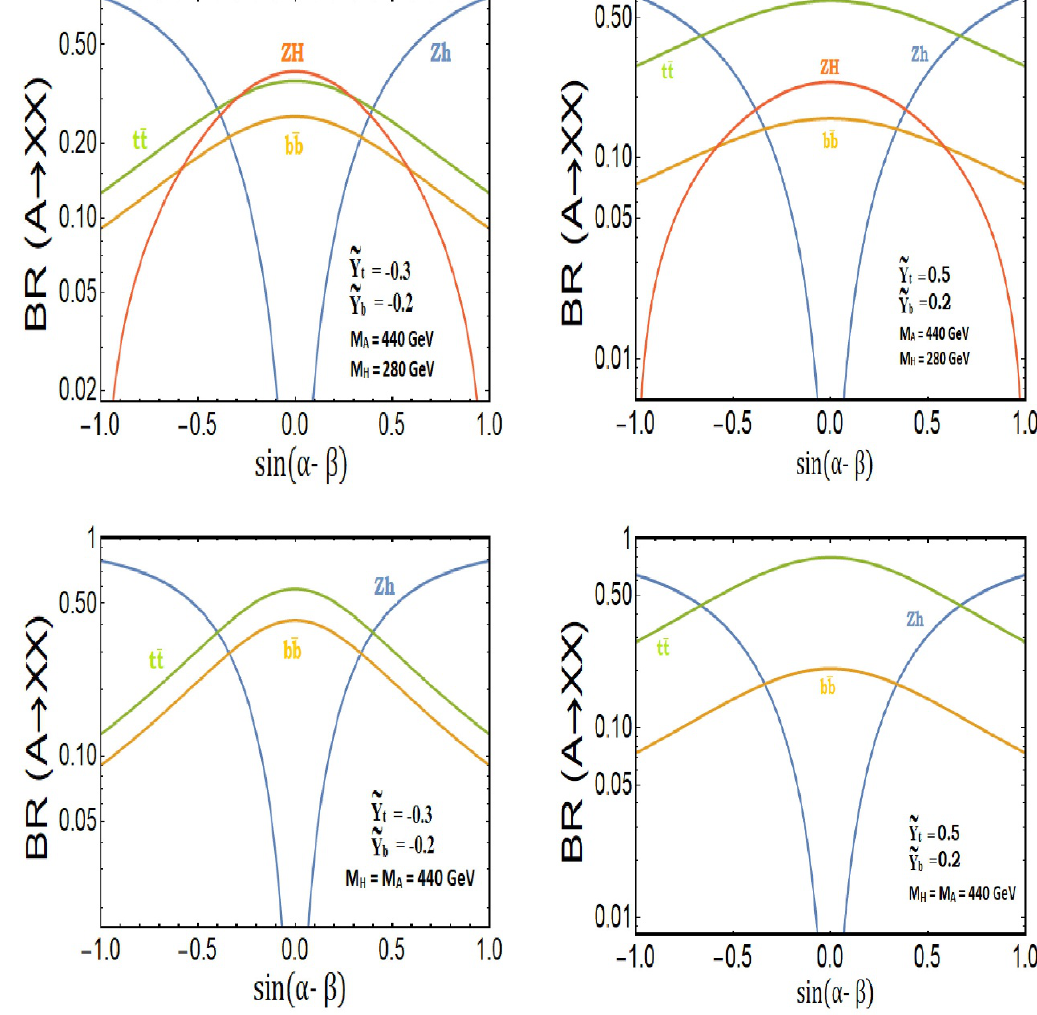
Figure 11 . Branching ratios A decaying into various modes as a function of sin( (cid:11) (cid:0) (cid:12) ) for M A = 500